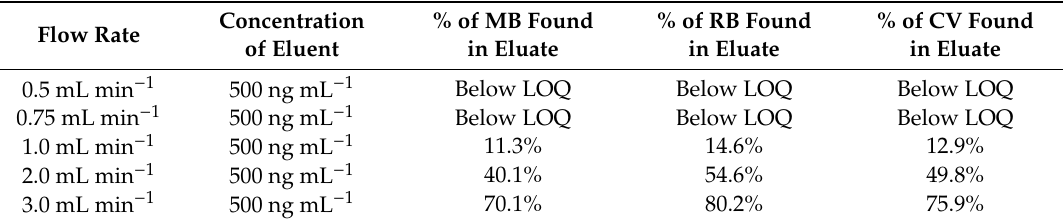
Table 5. Optimization of the flow rate of solid-phase extraction for the determination of methylene blue (MB), rhodamine B (RB) and crystal violet